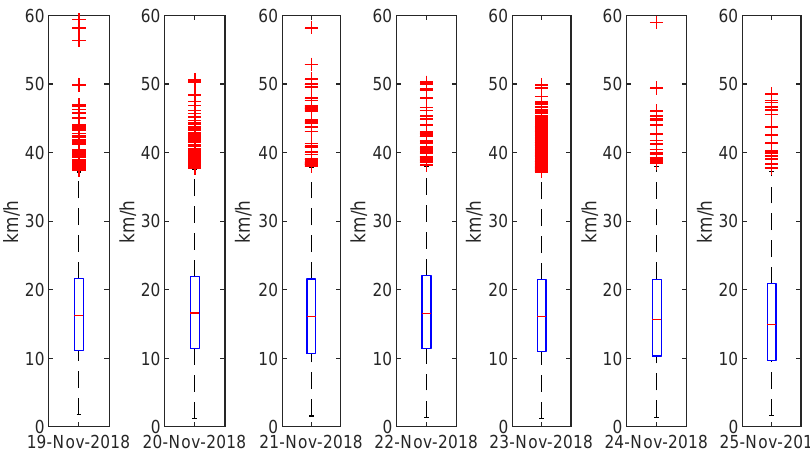
Figure 5. Boxplot of speed: week of 19 November 2018 (Mon) to 25 November 2018